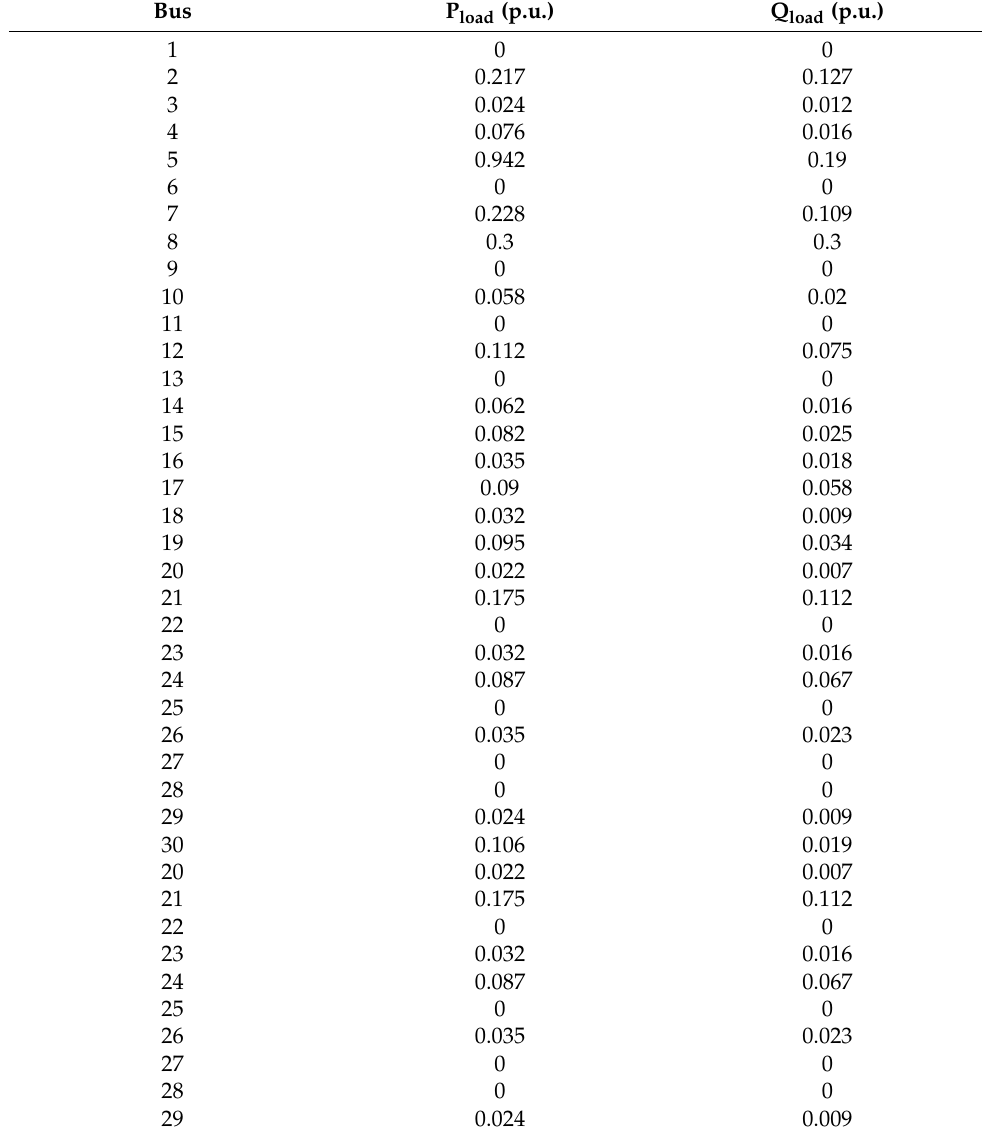
Table 1. IEEE 30-bus test system load values. Bus P load